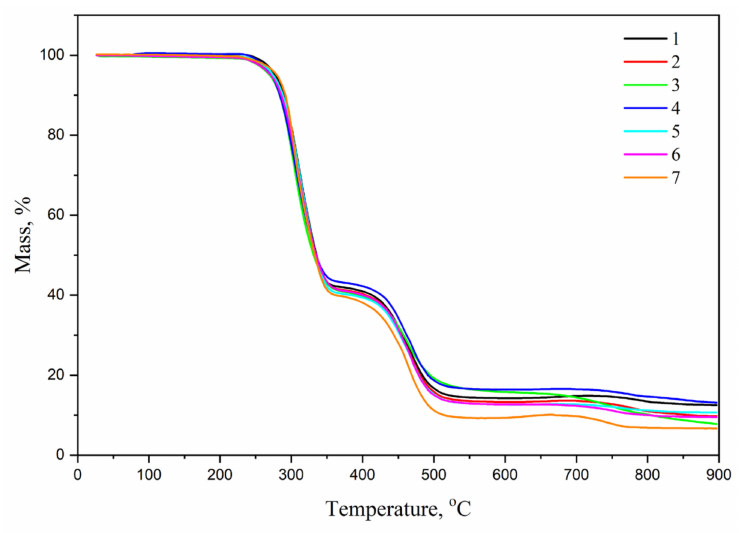
Figure 8. Thermograms for PVC: 1—0 rpm; 2—500 rpm; 3—1000 rpm; 4—1500 rpm; 5—2000 rpm; 6—2500 rpm; 7—PVC powder.